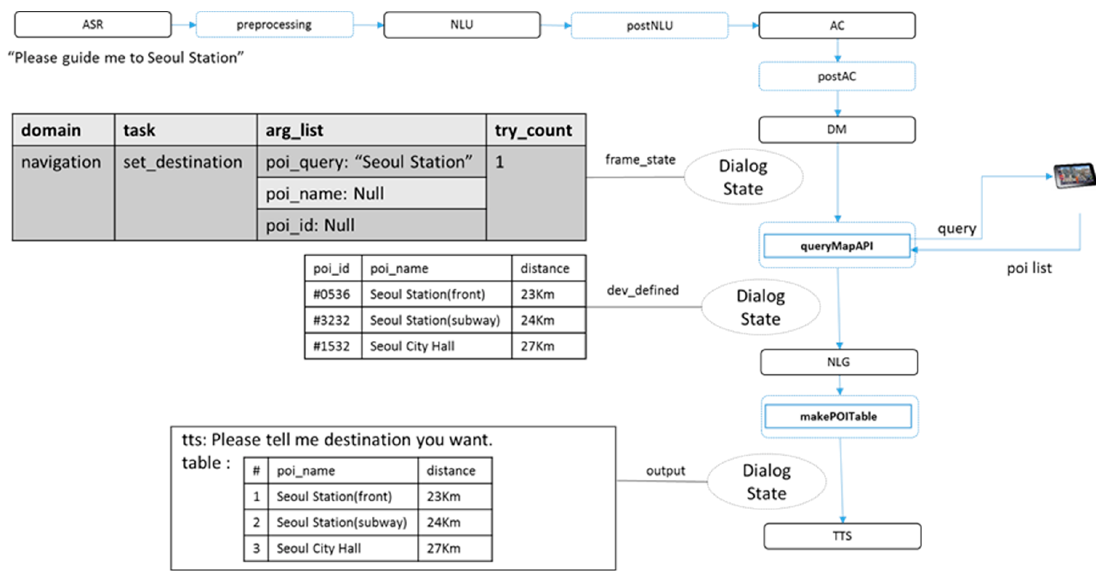
Figure 4. Example of external modules for navigation domain.